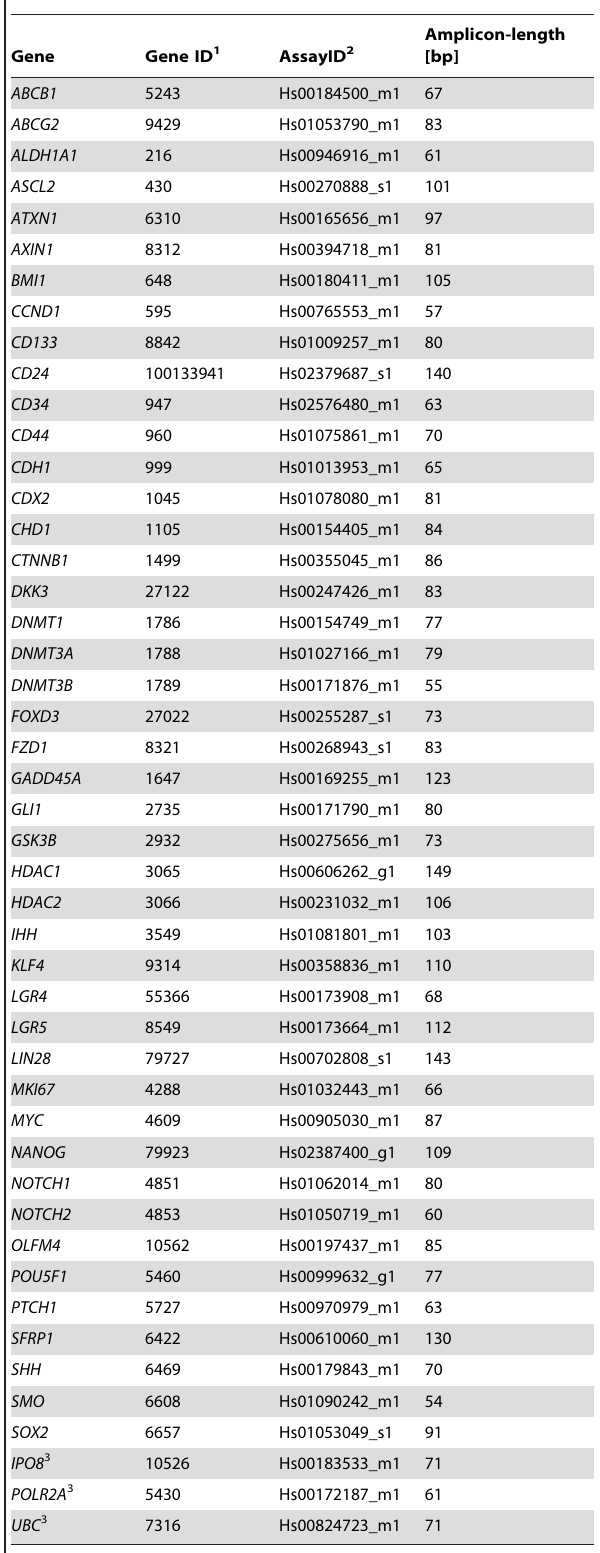
Table 2. Genes analysed by TaqMan H low density